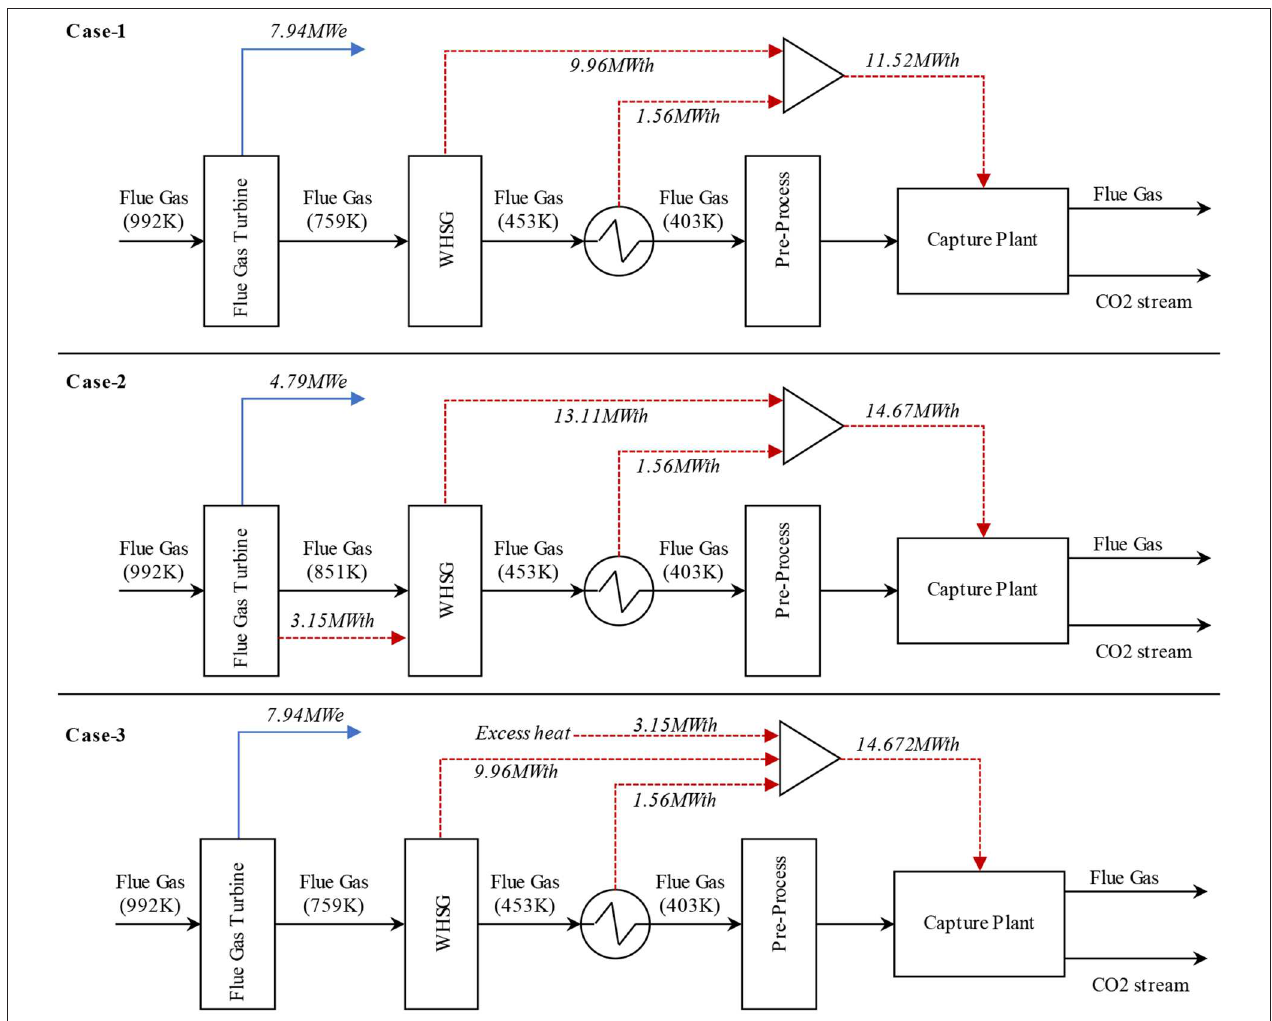
FIGURE 6 | Process flow diagram presenting three different heat integration options with post-combustion capture for the flue gas released from the regenerator of the FCC unit, adapted from Wei et al. (2018) with permission from Elsevier.